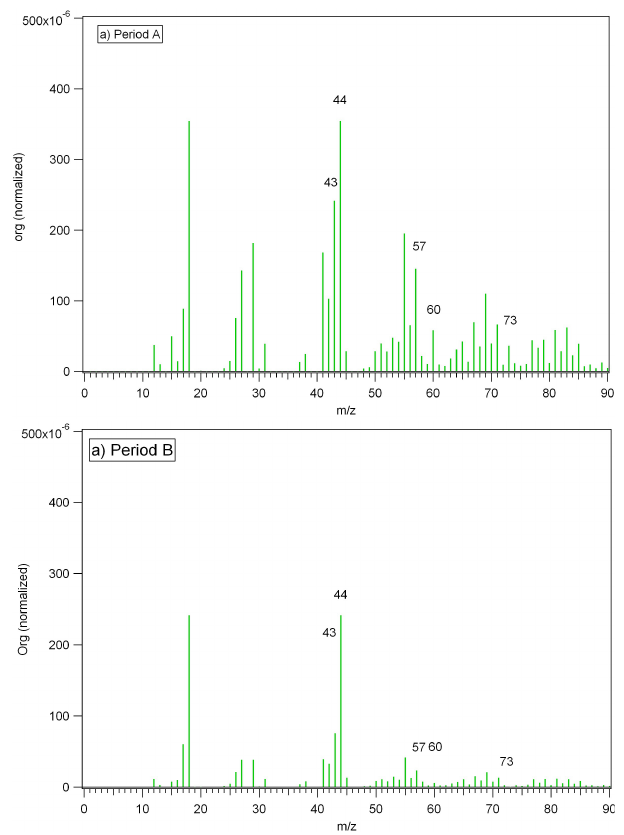
Fig. 5. Average mass spectra of organics, at the two different time periods: (a) Period A- during the biomass burning event, (b) Period B- after the burning event at noon time; Normalized to the total organic of the whole event (starting at the burning event till the day after).